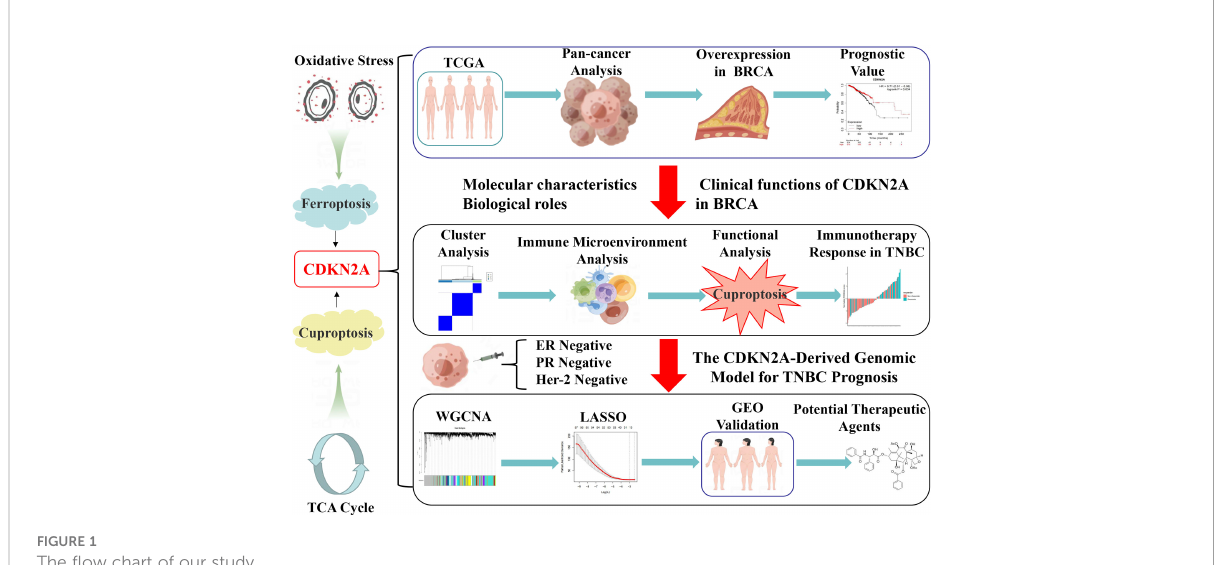
FIGURE 1 The fl ow chart of our